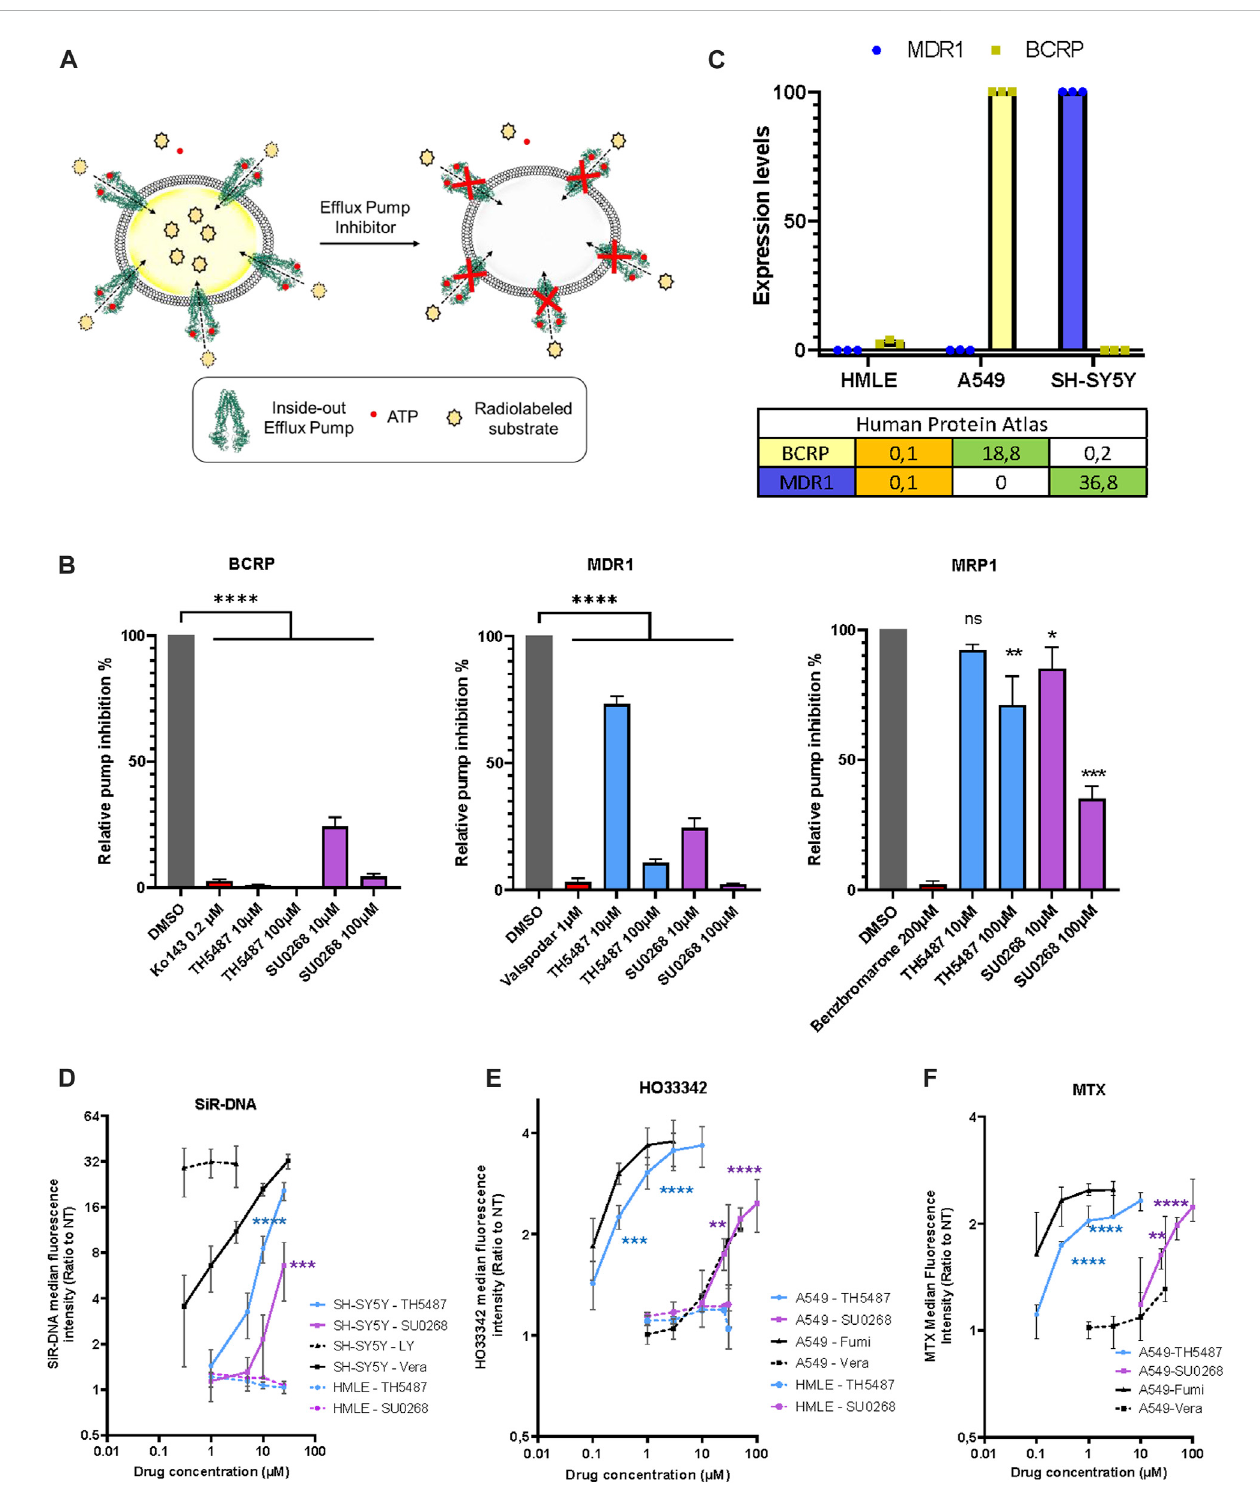
OGG1 inhibitors TH5487 and SU0268 inhibit the ef fl ux pump activity of BCRP, MDR1 and MRP1. (A) Scheme illustrating the vesicle transport assay. See results and material and methods sections for details. (B) Vesicles expressing inside-out BCRP, MDR1 or MRP1 were incubated with the corresponding selective inhibitors (Kol143 0.2 µM — Valspodar1 µM – Benzbromarone200 µM),TH5487andSU0268(10and 100 µM)andthespeci fi cpumpsubstrates(E3S- NMQ-E217 β G for BCRP, MDR1 or MRP1 respectively). In the graph, the substrate levels inside the vesicles are expressed as percentage of the ones in DMSOcontrolandreferredas relativepumpinhibition. Themeansandthes.d.ofthreereplicatesareshown. Thestatistical analysis wasperformedwithOne- way ANOVA (*) p < 0.05; (**) p < 0.01; (***) p < 0.001; (****) p < 0.0001. (C) The expression of levels of BCRP and MDR1 were quanti fi ed by RT-qPCR in the indicated cell lines (HMLE, A549, and SH-SY5Y). The table reports thenormalized transcript expressionvaluesas indicated in the Protein Atlas (nTPM). (D) SH- SY5Y and HMLE cells were stained with SiR-DNA in the presence of different concentrations of TH5487, SU0268 and the ef fl ux pump inhibitors Verapamil (Vera) and Zosuquidar/LY-335979 (LY). (E) A549 and HMLE cells were stained with HO33342 in the presence of different concentrations of TH5487,